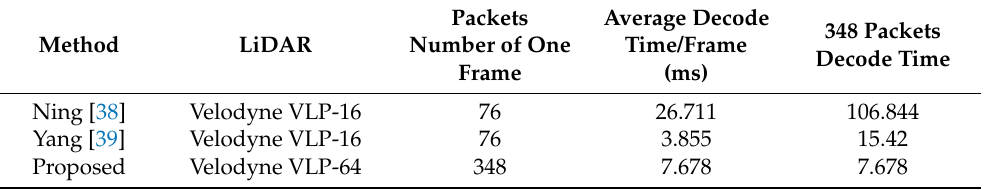
Table 4. Comparison table of experimental